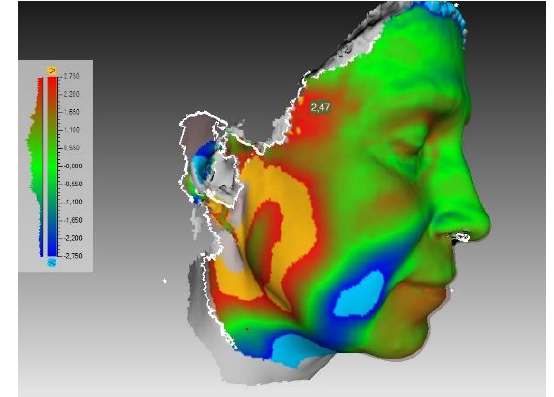
Figure 1. The gravity test. Geodesic measurements. Green – no volume changes. Blue – diminishing of volume. Red – augmentation of volume. The isolated excess of volume in temporal area marked with a surface distance value.